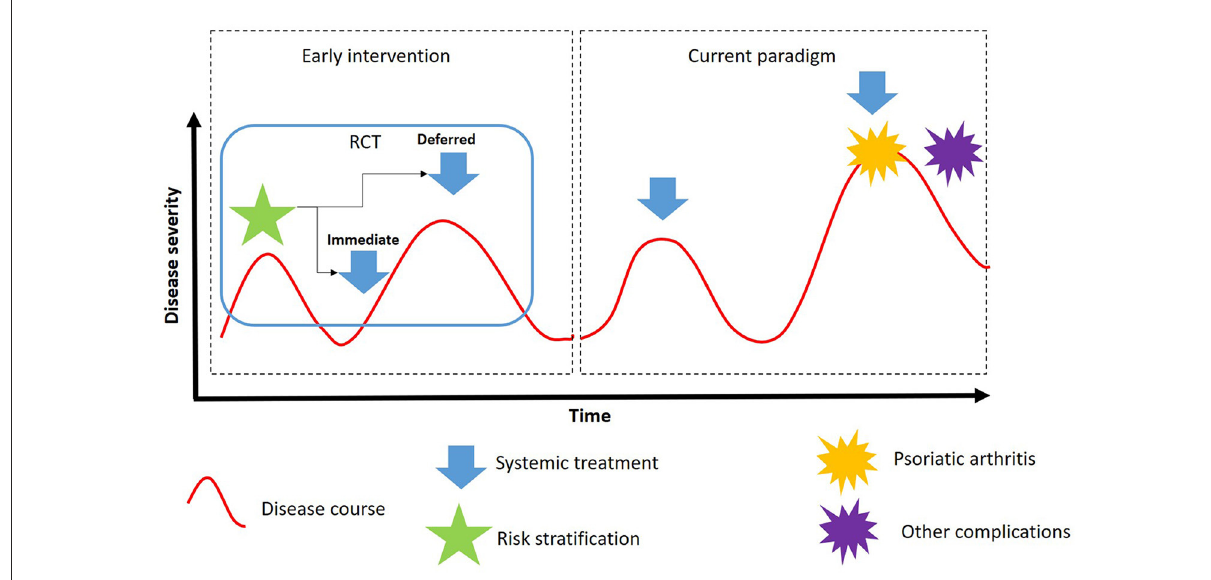
FIGURE1 Proposed model to test the role of early intervention in plaque psoriasis (RCT, randomized controlled